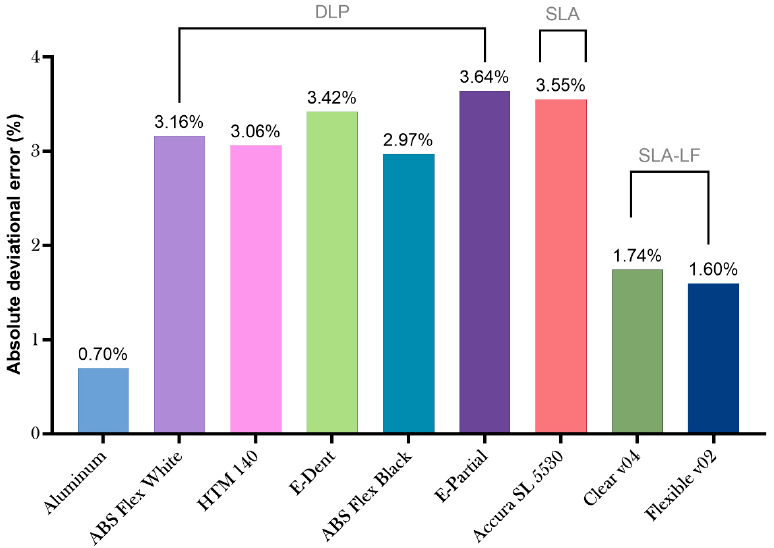
Figure 5. Absolute deviational error of assessed materials.